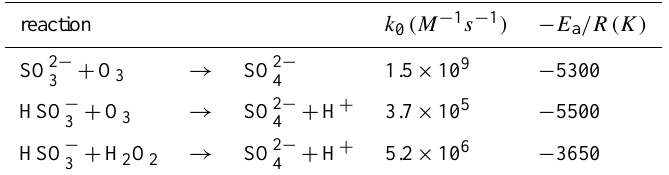
Table 4. Aqueous-phase reactions.